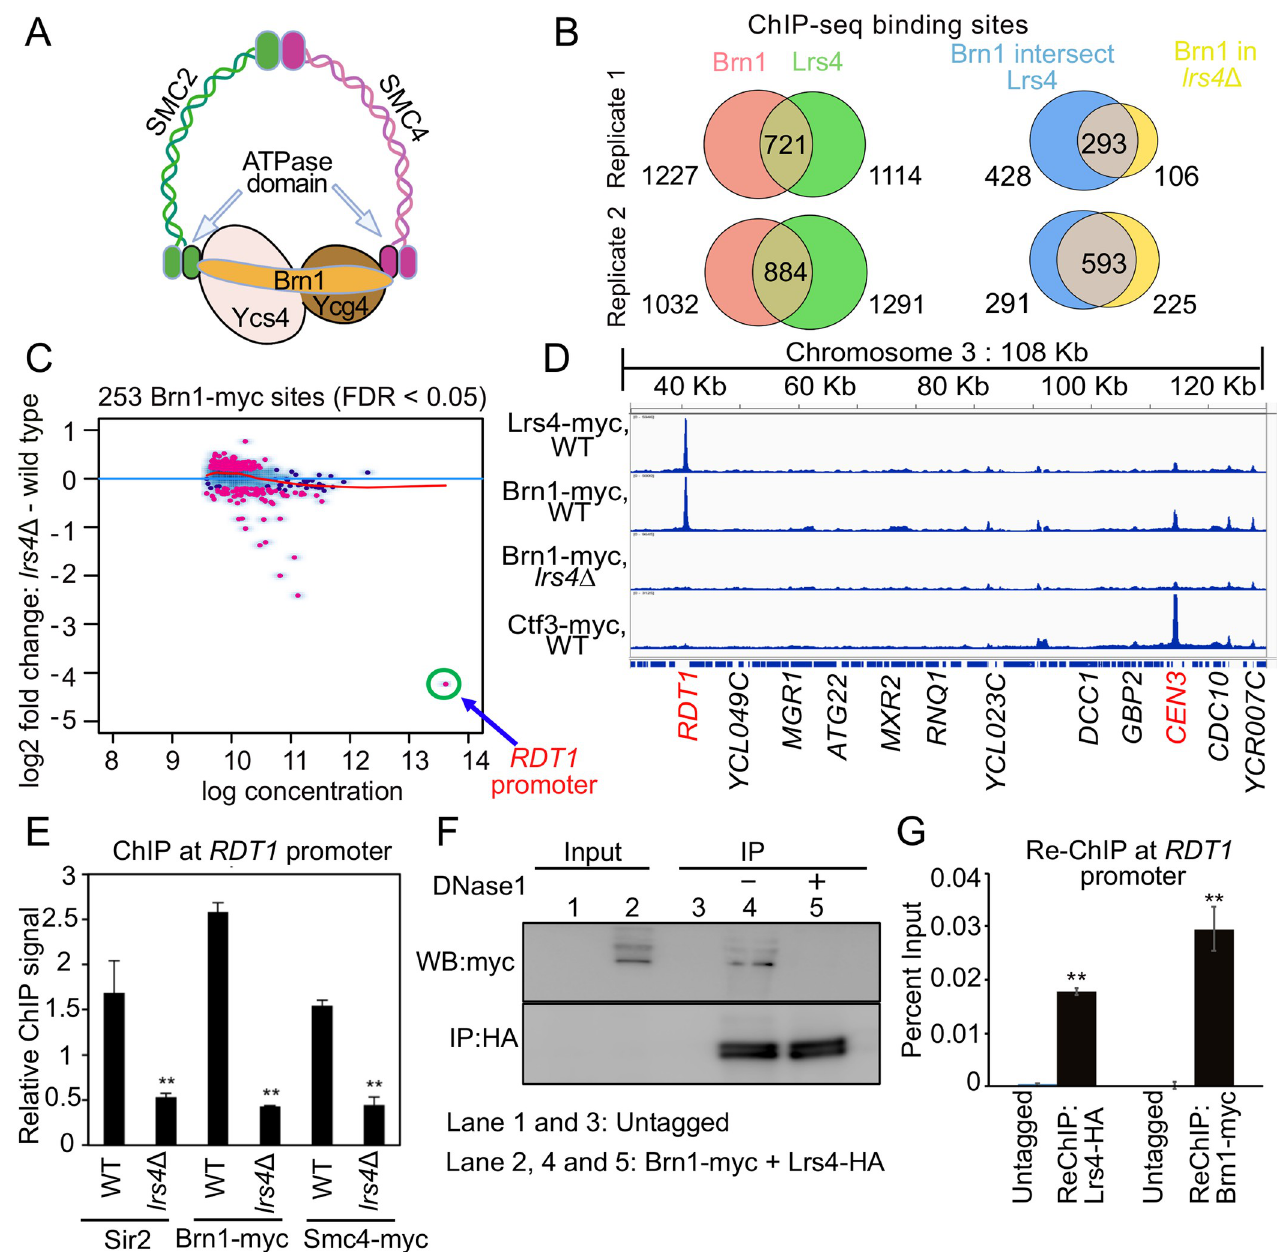
Fig 2. Cohibin recruits condensin to the RDT1 promoter in MAT a cells. ( A ) Schematic of budding yeast condensin subunits. ( B ) Venn diagrams of overlapping ChIP-seq peaks for Brn1-myc and Lrs4-myc in MAT a cells from two independent replicates on the left. Among overlapping peaks, the number that change in the lrs4 Δ mutant are indicated in right Venn diagrams. Peaks that overlap with Ctf3-myc peaks were subtracted from each dataset. ( C ) MA plot indicating differential Brn1-myc binding between WT and lrs4 Δ . Red dots are peaks significantly different between WT and lrs4 Δ with FDR < 0.05. Blue dots are peaks not differentially bound. RDT1 promoter peak is highlighted. ( D ) IGV screenshot of chrIII peaks for Brn1-myc, Lrs4-myc, Ctf3-myc, and Brn1-myc in the lrs4 Δ mutant. Ctf3 is a centromere-specific control. ( E ) ChIP analysis at RDT1 showing decreased enrichment of Sir2, Brn1-myc, and Smc4-myc in lrs4 Δ mutant. ( F ) Co-IP assays from cell lysates were performed with an untagged strain or a strain with Lrs4-HA/Brn1-myc. DNase I digestion disrupts the coimmunoprecipitation. ( G ) Quantitative ChIP-reChIP PCR analysis of condensin (Brn1-myc) and cohibin (Lrs4-HA) co-occupancy at the RDT1 promoter. N = 3 biological replicates for each ChIP experiment; * p < 0.05, ** p < 0.005 using two-sided t-test assuming unequal